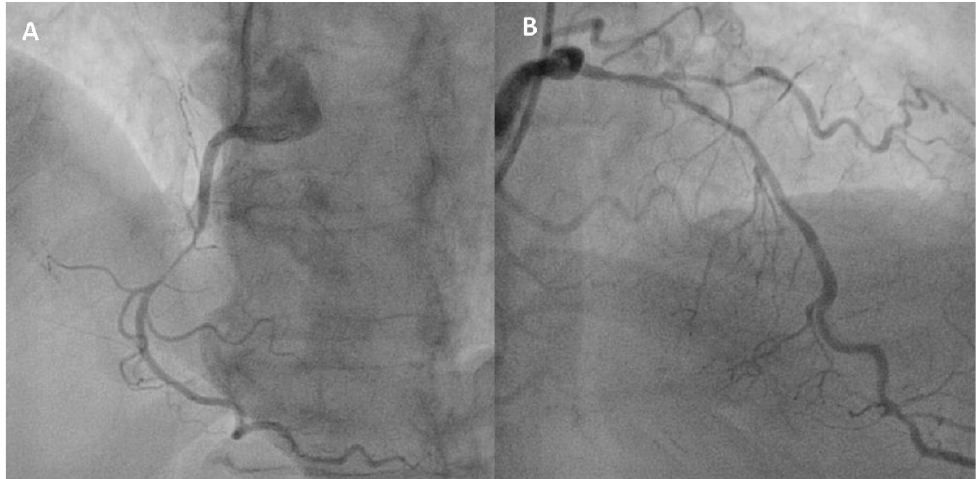
Figure 1. Coronary angiography in the patient case described in the case vignette. ( A ) The right coronary artery shows a tight stenosis in the mid segment (culprit lesion). ( B ) The left anterior descending coronary artery shows a long 75% maximum diameter stenosis in the proximal and mid segments.